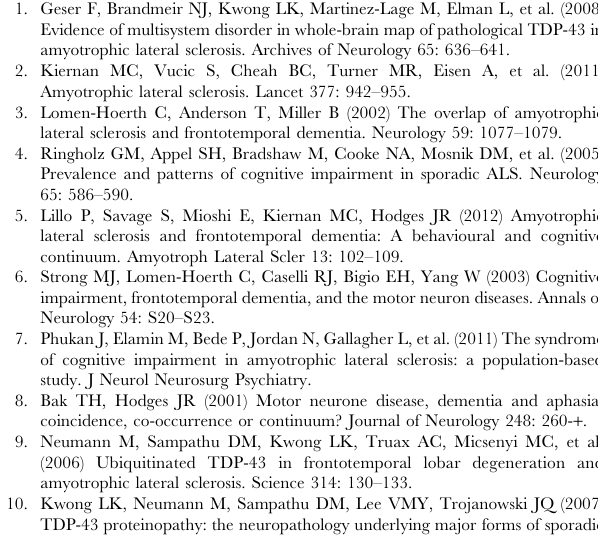
Figure S1 Grey matter atrophy of patients compared to controls. Voxel-based morphometry analysis showing brain area atrophy for A ) bvFTD vs. controls, B ) ALS-FTD vs. controls, and C ) ALS vs. controls. Clusters are overlaid on the MNI standard brain (t= 2.41). Coloured voxels show regions that were significant in the analyses for p , 0.05 FWE corrected, except for ALS vs. controls which was thresholded at p , .001, uncorrected, and a cluster threshold of 20 contiguous voxels. (TIF) Figure S2 White matter changes of patients compared to controls. Diffusion tensor imaging analysis showing white matter changes for A) bvFTD vs. controls, B ) ALS-FTD vs. controls, and C ) ALS vs. controls. Clusters are overlaid on the MNI standard brain (t =2.41). Coloured voxels show regions that were significant in the analyses for p , 0.05 FWE corrected, except for ALS vs. controls which was thresholded at p , .001, un- corrected, and a cluster threshold of 20 contiguous